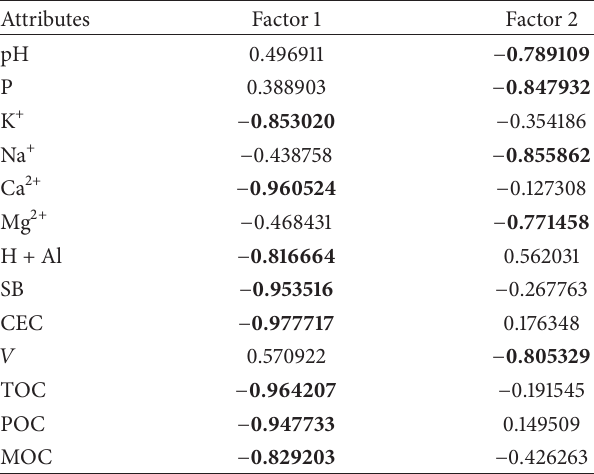
Table 5: Correlation between the first and the second factors and the variables adopted in the present